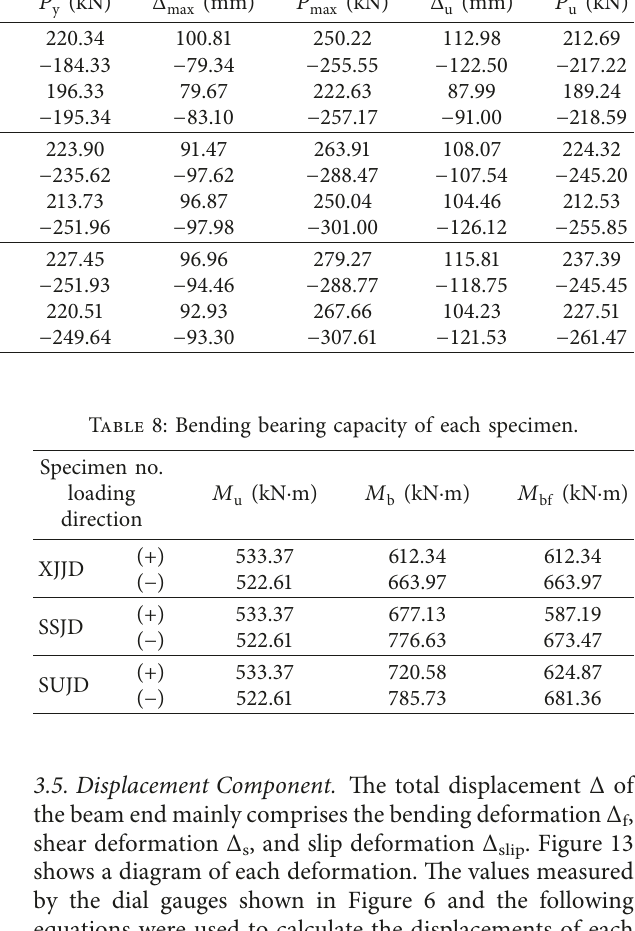
Figure 12: Skeleton curves for specimens: (a) north beam and (b) south beam. Table 6: Test values of feature points of specimens. Specimen no.